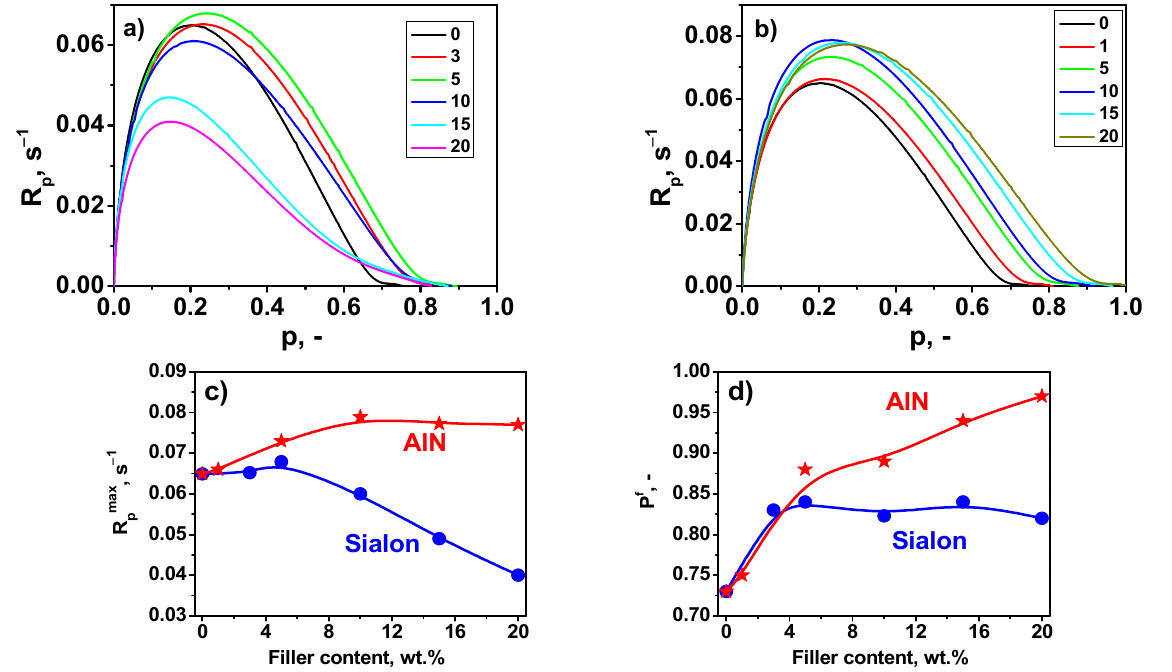
Figure 3. Dependence of the polymerization rate R p on double bond conversion p (at 25 °C) for the: ( a ) monomer/Sialon, ( b ) monomer/AlN, ( c ) maximum polymerization rate R pmaks , and ( d ) final bond conversion ( p f ) for formulations at various filler content (in wt.%). The lines are guides for the eye. Varnish compositions containing Sialon show a slightly different polymerization process. The positive effect of Sialon is very slight, and the slowing-down effect dominates. This is more apparent in Figure 2c showing the changes R pmax of both compositions with an increasing content of filler. It can be seen that the highest R pmax value is achieved by the composition containing 3 wt.% of Sialon addition. An additional increment in filler concentration results in a reduction in the polymerization rate.